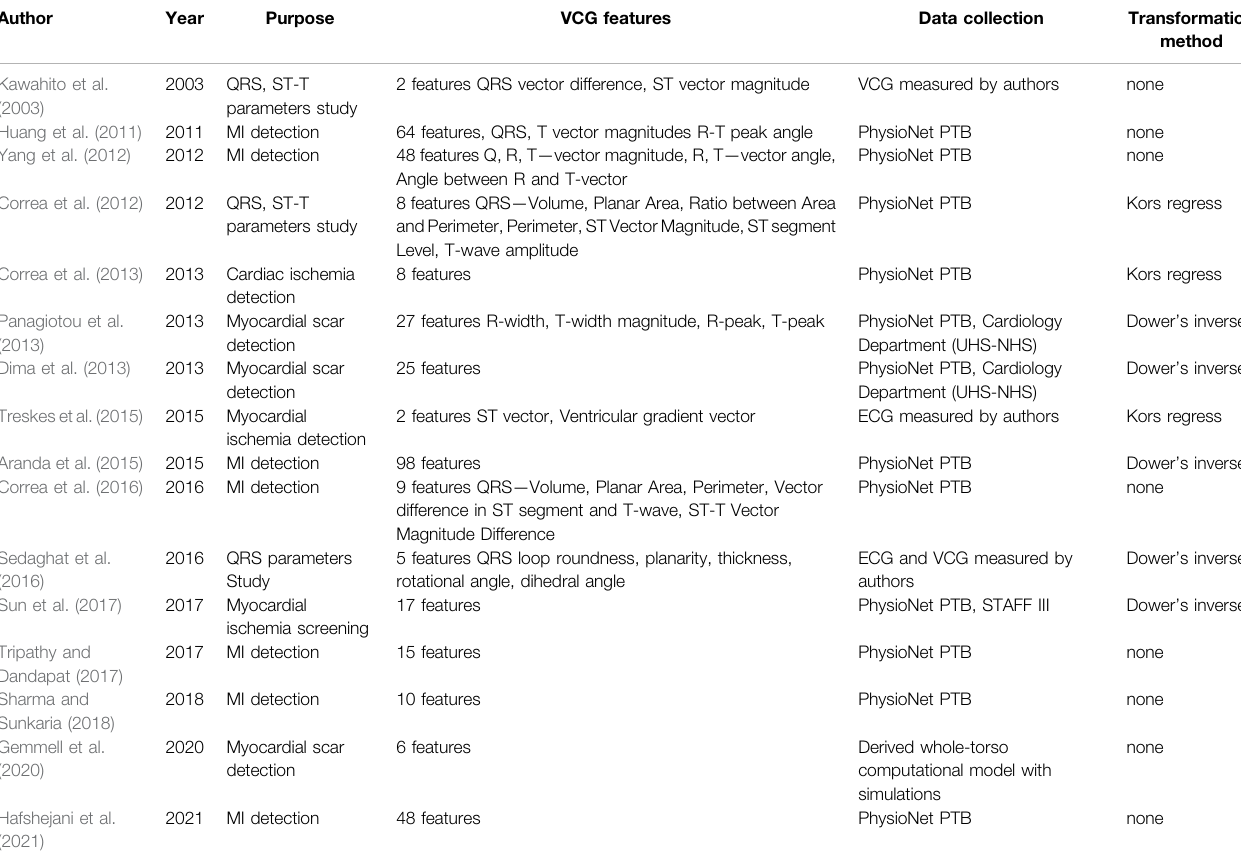
TABLE 9 | An overview of important comparative